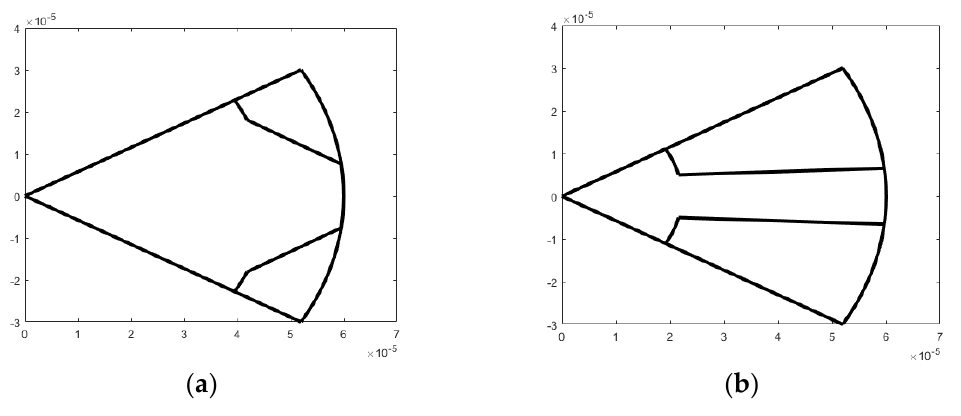
Figure 6. Geometry of device A ( a ) and B ( b ).